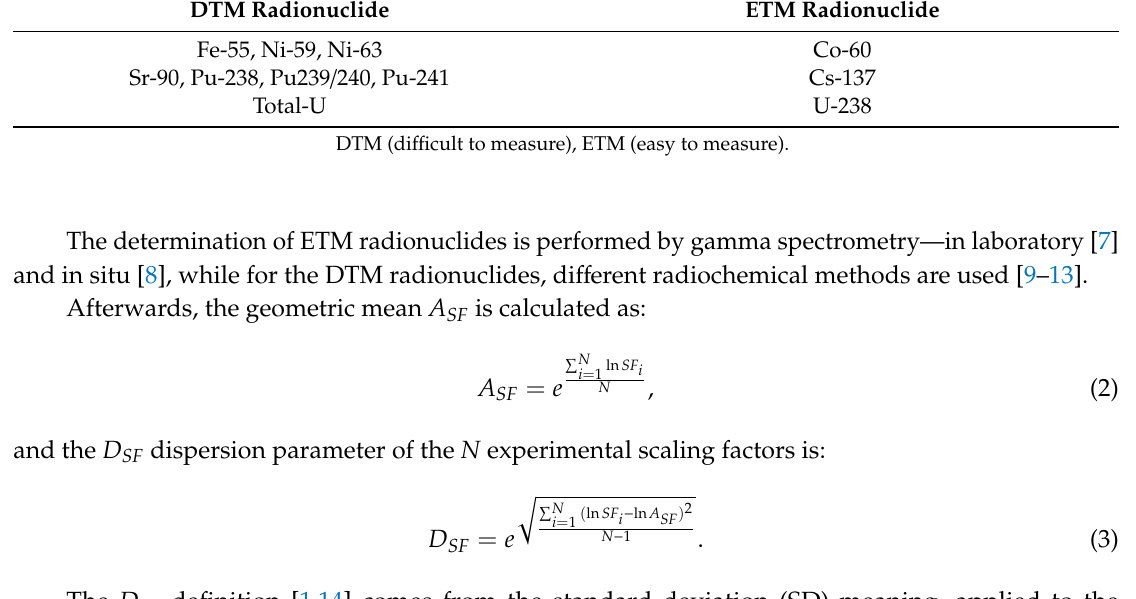
Table 1. Reference key nuclide for di ff erent DTMs. DTM Radionuclide ETM